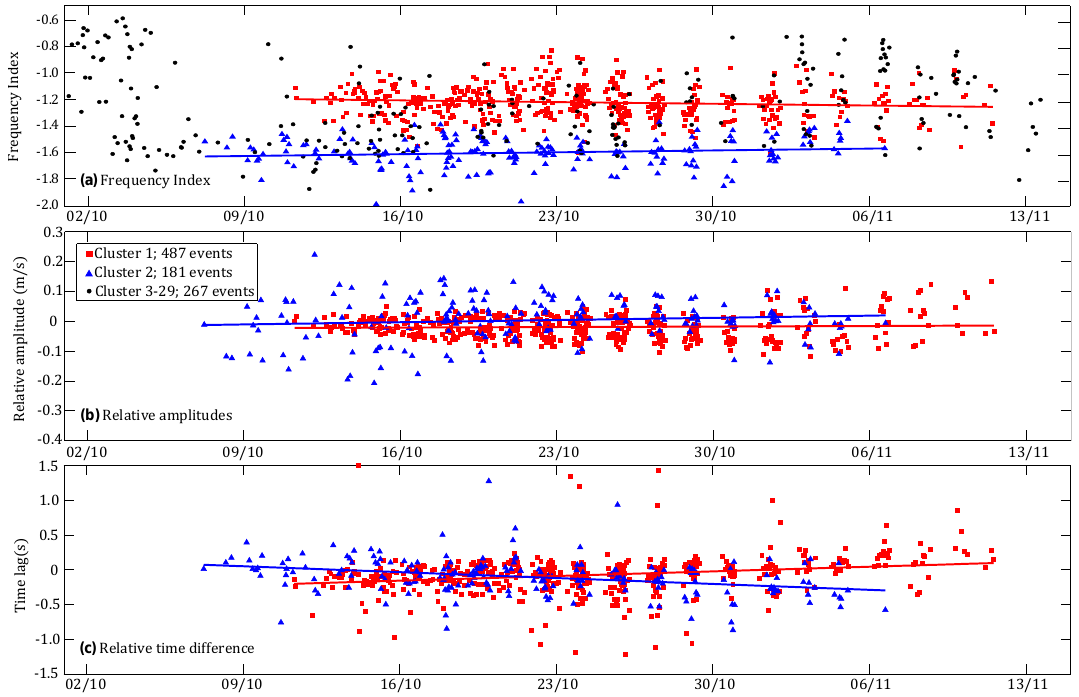
Figure 4. (a) The frequency index of earthquakes in clusters 1, 2, and 3–29. (b) Relative amplitudes of earthquakes in clusters 1 and 2, as measured using singular value decomposition. (c) The relative time difference (i.e. time lag) of each earthquake in clusters 1 and 2, as measured using cross-correlation against the first principal component. In each panel the linear best fit for each cluster is plotted. Relative amplitudes and time differences were not calculated for clusters